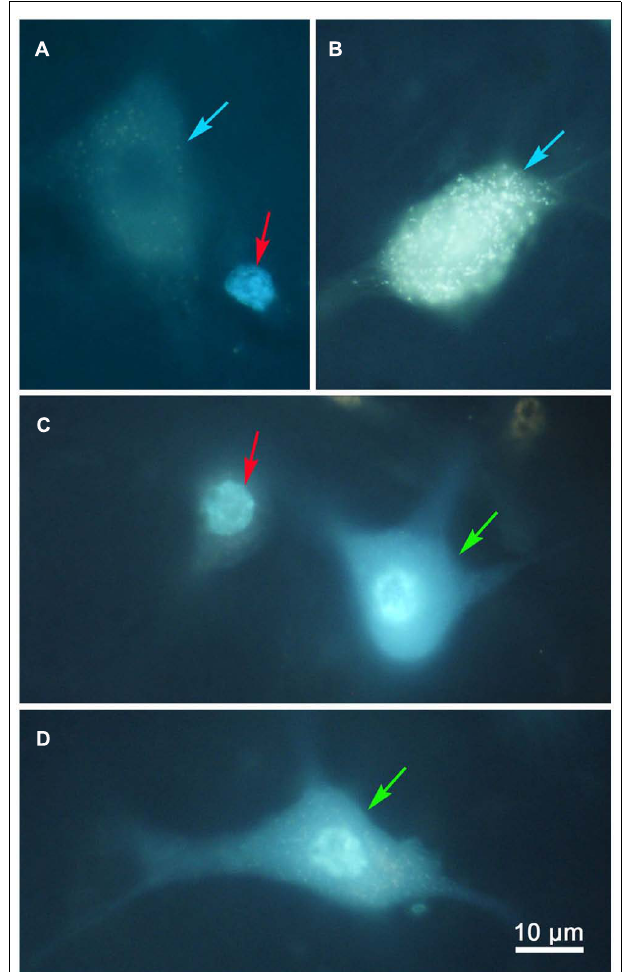
FIGURE 2 | Photomicrographs of singly (A,B) and doubly (C,D) labeled MRF reticulotectal neurons. Fluorogold produced label in the cytoplasm of the singly labeled cells [ (A,B) , blue arrows]. Diamidino yellow just labels the nucleus [ (A) , red arrows]. Doubly labeled neurons show label in both the cytoplasm and nucleus [ (C,D) , green